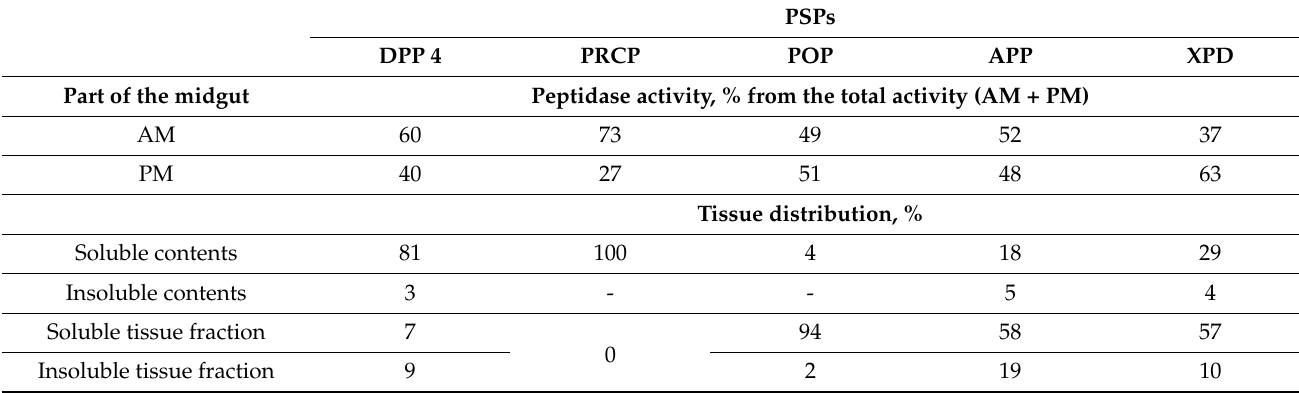
Table 6. Localization of T. molitor larval midgut peptidases *.